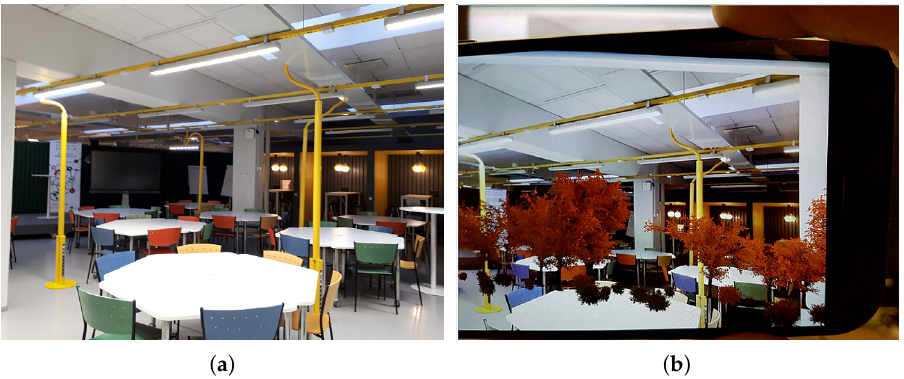
Figure 12. View in Business Kitchen space, ( a ) original view, ( b ) view enhanced with AR objects able to change the color based on the state of the